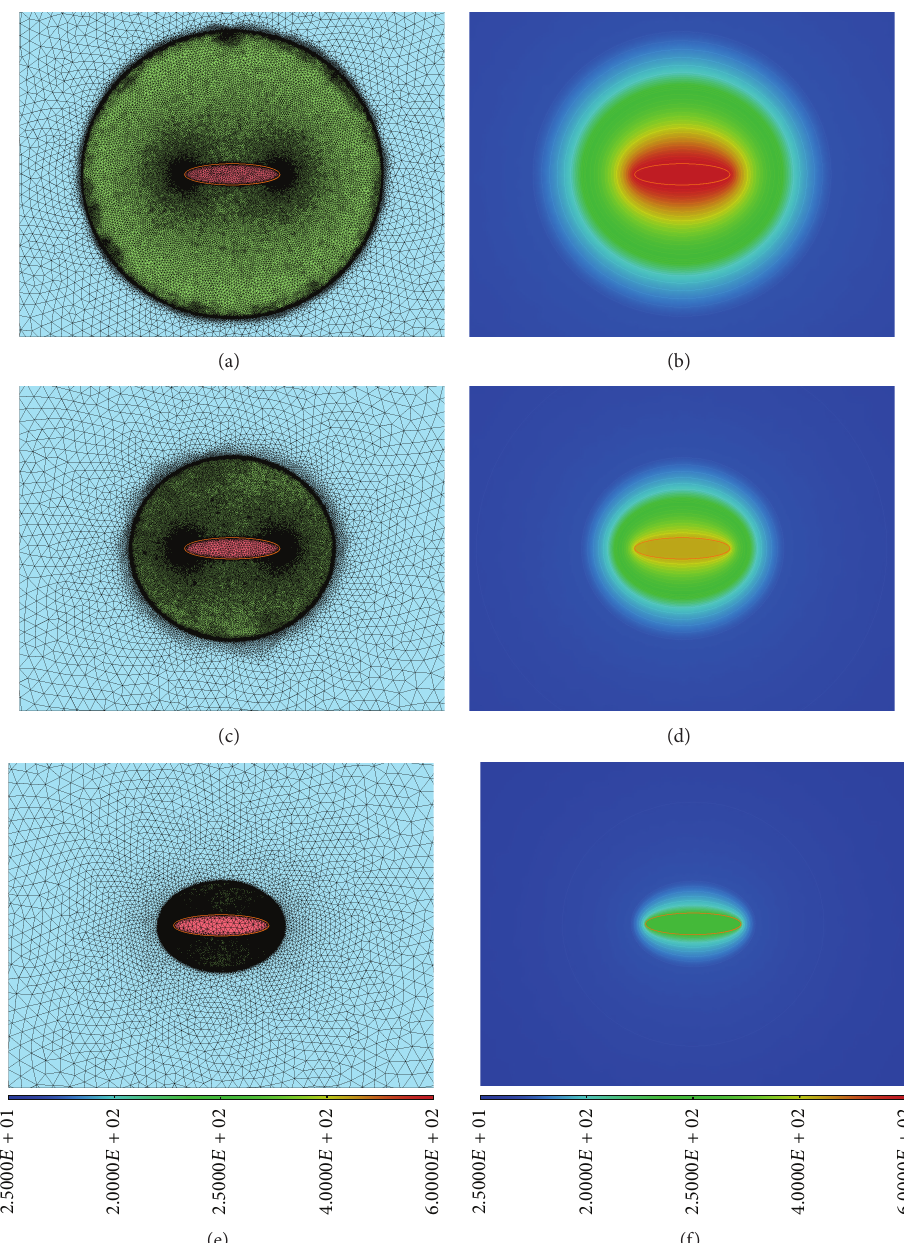
Figure 2: Adapted meshes 𝑀 𝐹 ((a), (c), and (e)) and temperature map 𝑇 on 𝑀 𝐹 ((b), (d), and (f)) for wavelengths 𝜆 = 950 , 1000 , and 1050 nm,